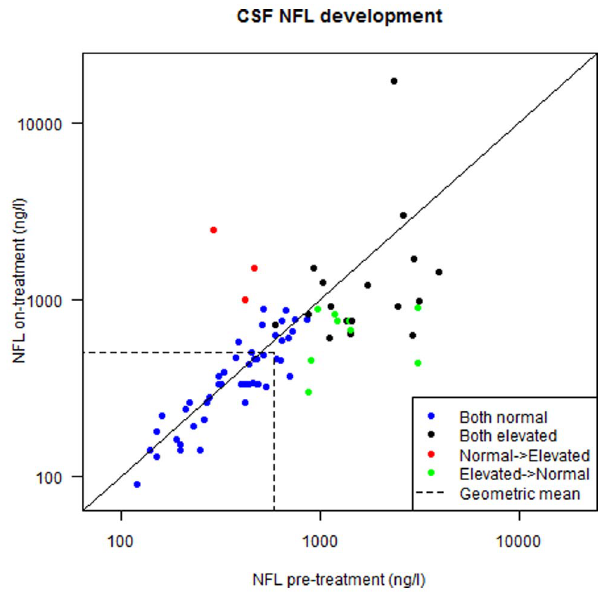
Figure 4. CSF NFL levels before-after combination antiretrovi- ral treatment (cART) initiation. Overall CSF NFL levels decreased in 63% of the patients after initiation of cART (p , 0.01), demonstrated as a lower CSF NFL geometric mean (dotted line) after initiation of cART. 33% of the patents had elevated levels of CSF NFL at baseline and 81% of those exhibited reduction in their CSF NFL levels after treatment (p , 0.01). 35% of patients with pathological CSF NFL at baseline normalized their levels (green colored). Those with normal CSF NFL at baseline exhibited no significant reduction in CSF NFL (blue colored). Three patients with normal baseline CSF NFL exhibited elevated levels of CSF NFL after cART initiation (red colored).